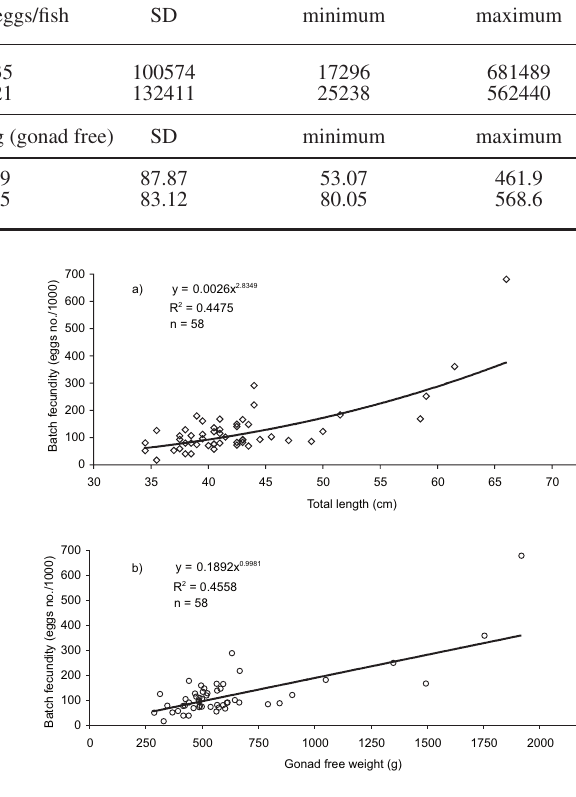
Table 5. – Catalan and northern Tyrrhenian Sea fecundity values for hake. SD, Standard Deviation. mean num. eggs/fish